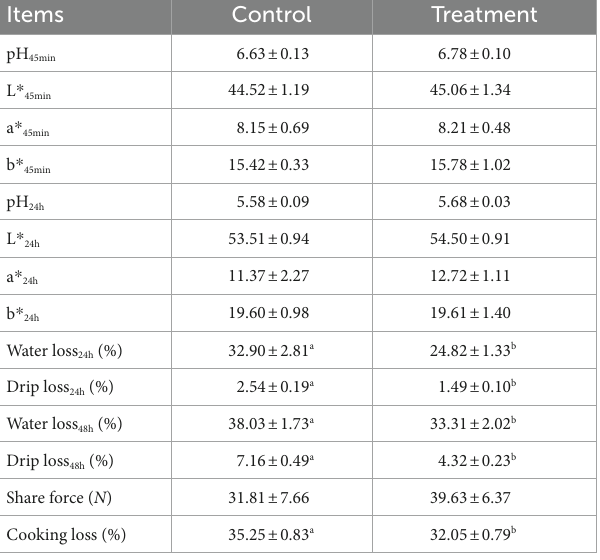
TABLE 2 Effect of grape residue meal on quality traits of longissimus thoracis in